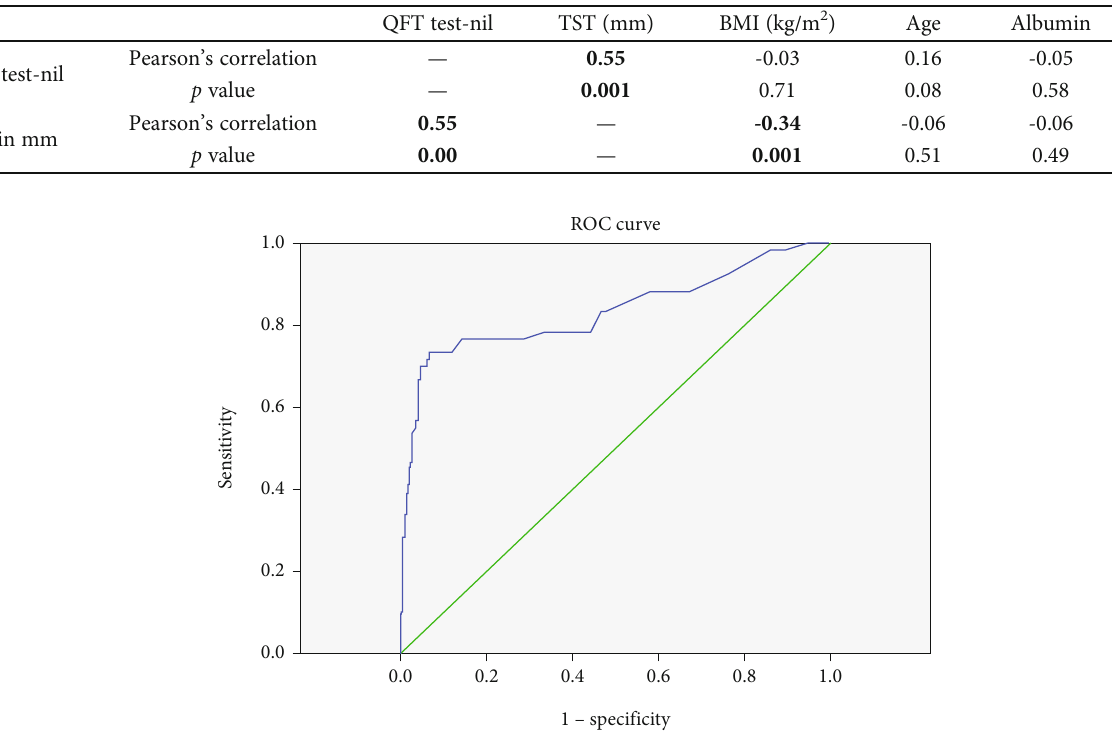
Figure 3: ROC curve for TST in mm with IGRA